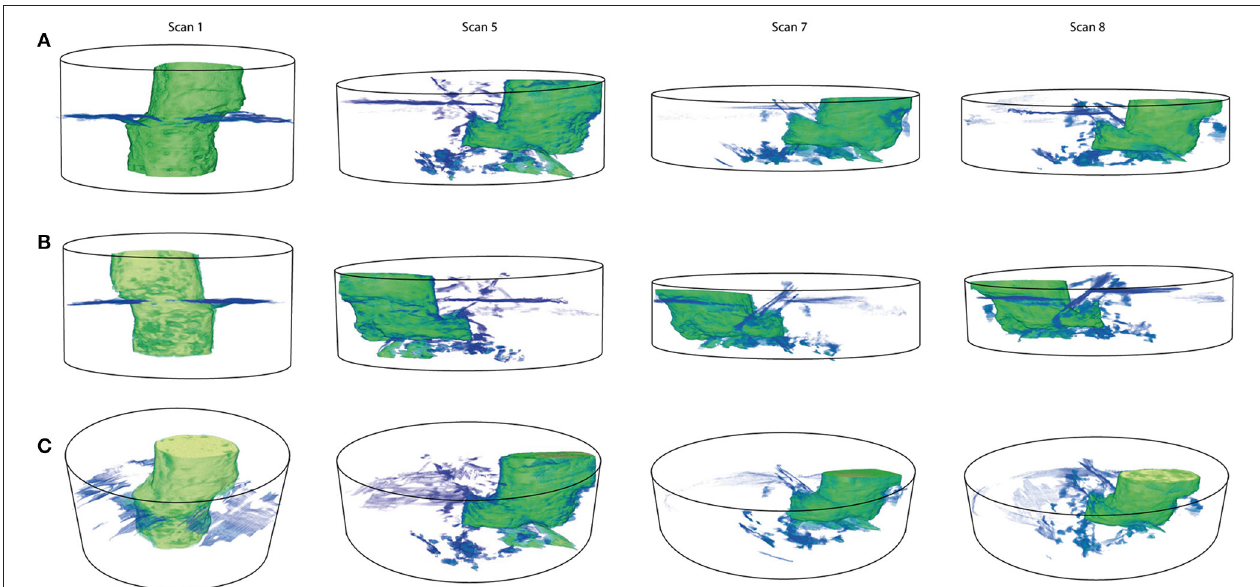
FIGURE 3 | Volume rendering of tomographic scans at three orientations (A–C) . A masking technique is applied to segment volumes of interest but preserve grayscale values within segmented areas, and therefore, attenuation value of volumes of interest. Blue, lowest attenuation; green to yellow, highest attenuation. Only attenuation from Au melt is